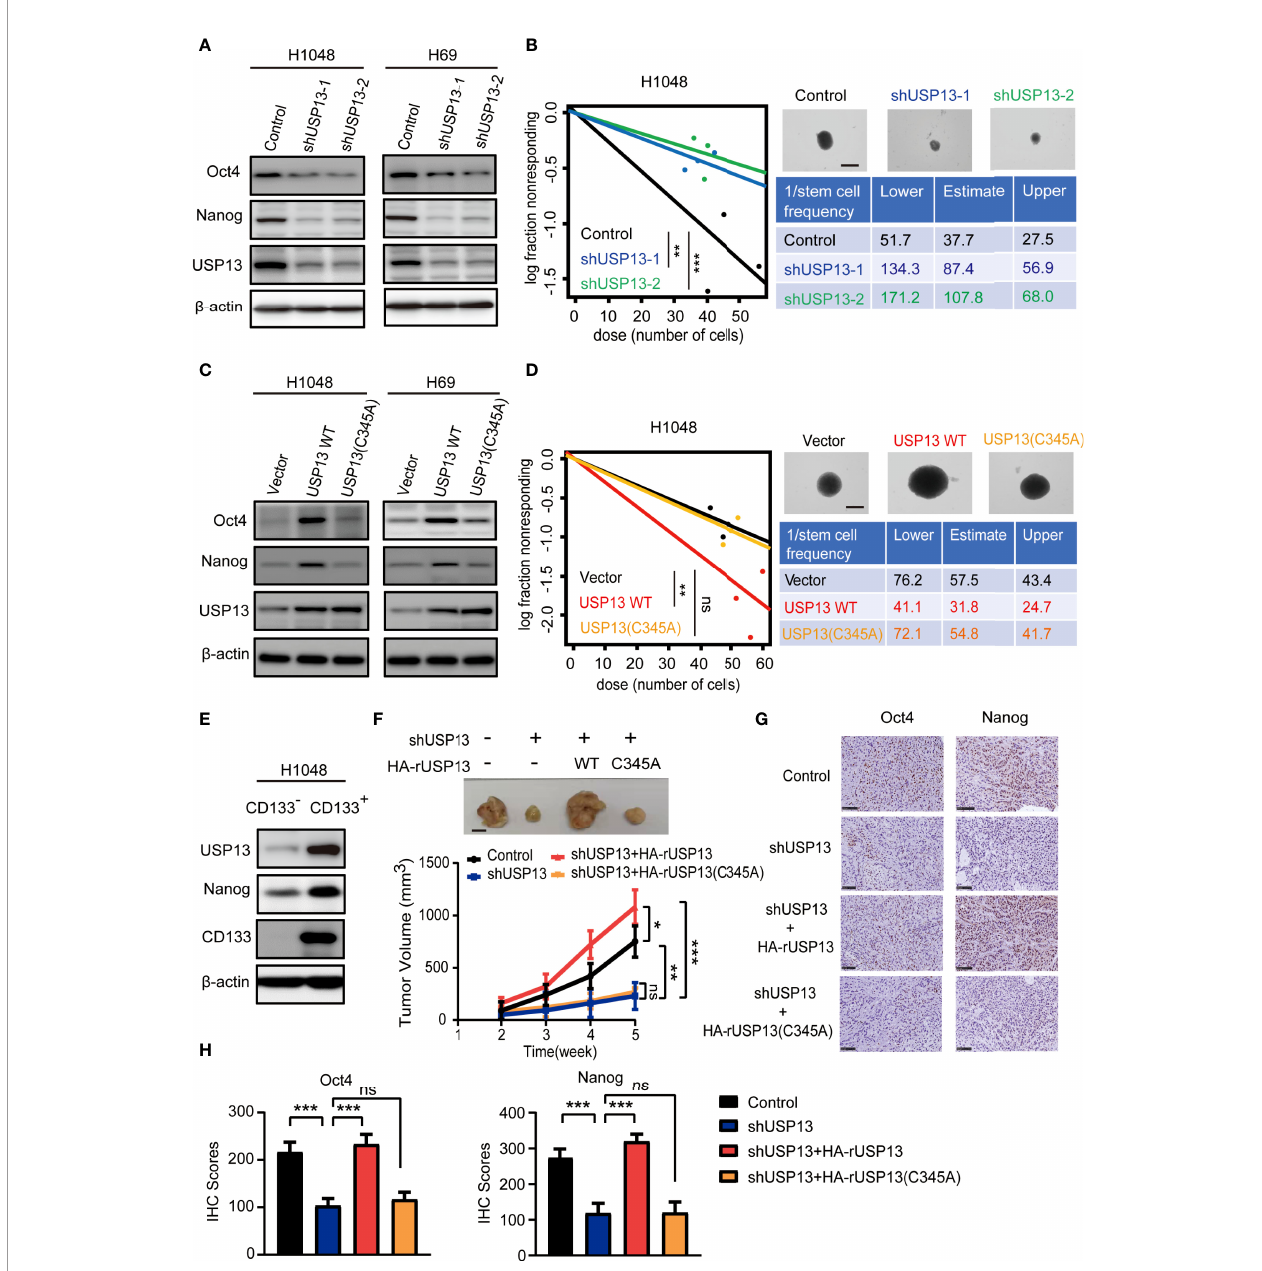
FIGURE 2 | USP13 promotes SCLC CSC-like properties and tumor growth. (A) Immunoblot analyses of H1048 (left) and H69 (right) cells with or without USP13 depletion were performed with the indicated antibodies. (B) Left: ELDA was performed in H1048 cells with or without USP13 knockdown. Representative sphere images (top right) and stemness frequency illustration of the cells with the upper and lower 95% con fi dence intervals (bottom right) are shown. Scale bars, 50 m m. Data represent the means ± SD of wells. Two-tailed student ’ s t-test was used. ** p < 0.01, *** p < 0.001. (C) Immunoblot analyses of H1048 (left) and H69 (right) cells with or without WT USP13 or catalytically inactive USP13 (C345A) mutant overexpression were performed with the indicated antibodies. (D) Left: ELDA was performed in H1048 cells with or without WT USP13 or catalytically inactive USP13 (C345A) mutant overexpression. Representative sphere images (top right) and stemness frequency illustration of the cells with the upper and lower 95% con fi dence intervals (bottom right) are shown. Scale bars, 50 m m. Data represent the means ± SD of wells. Two-tailed student ’ s t-test was used. ns, not signi fi cant. ** p < 0.01. (E) CD133 - and CD133 + subpopulations of H1048 cells were sorted. Immunoblot analyses were performed with the indicated antibodies. (F) Tumor formation in immunode fi cient mice transplanted with H1048 cells with or without USP13 depletion, or shUSP13 cells combined with reconstituted expression of WT HA-rUSP13 or catalytically inactive HA-rUSP13 (C345A) mutant. Tumor sizes and volumes were measured and calculated (n=5 per group). Data represent the means ± SD of fi ve mice per group. Two-tailed student ’ s t-test was used. ns, not signi fi cant. * p < 0.05, ** p < 0.01, *** p < 0.001. (G, H) IHC staining of mouse tumor tissues was performed with the indicated antibodies. Representative images are displayed ( G ), and IHC scores were calculated ( H ). Scale bars: 100 m m. Data represent the means ± SD of triplicate samples. Two-tailed student ’ s t-test was used. ns, not signi fi cant. *** p <